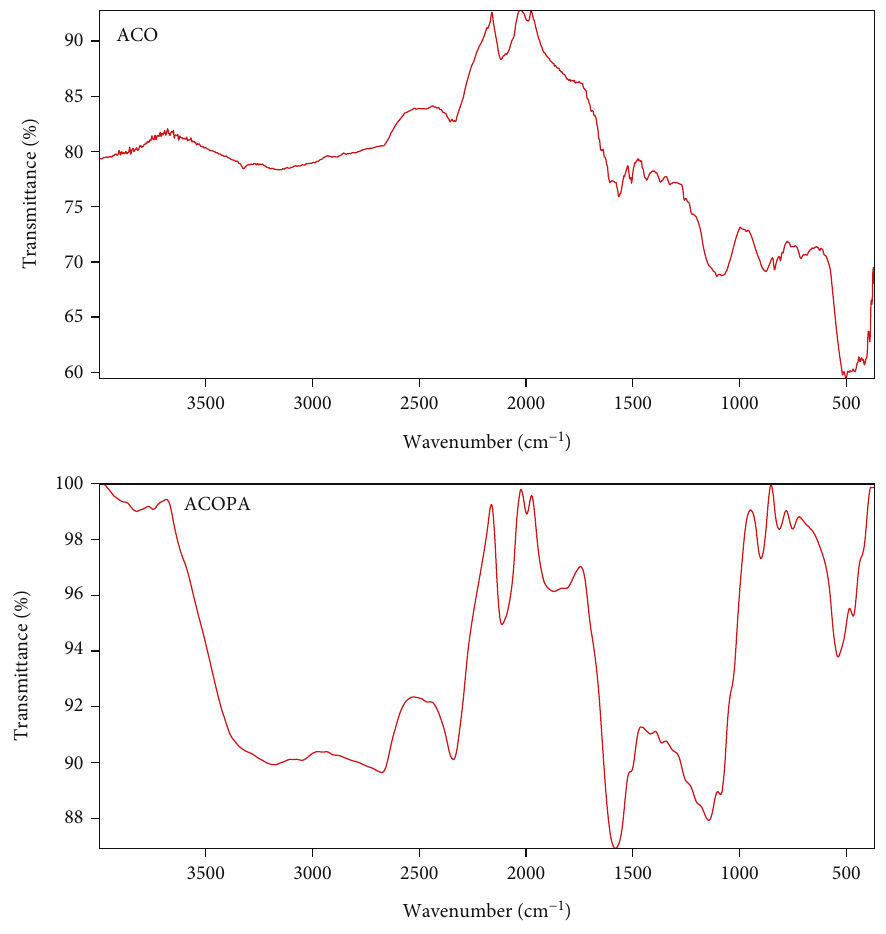
Figure 1: FT-IR analysis of ACO and ACOPA.